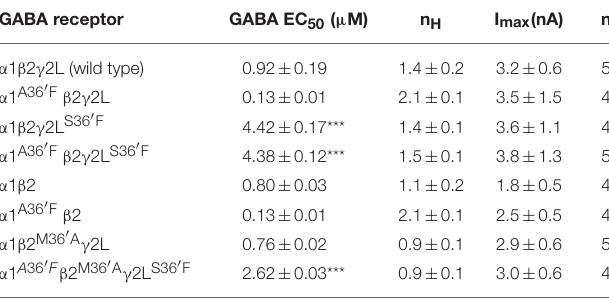
TABLE 1 | Concentration-response curve fit parameters for GABA at wild type and mutant GABA A Rs.